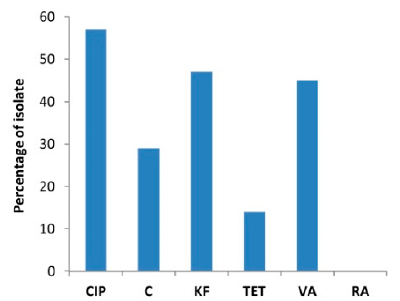
Figure 5. Characterization of the bacteria collection for antibiotic resistance. Percentage of strains resistant to CIP = ciprofloxacin (5 µg); C = chloramphenicol (30 µg); KF = cephalotin (30 µg); TET = tetracycline (30 µg); VA = vancomycin (30 µg); RA = rifampicin (5 µg).